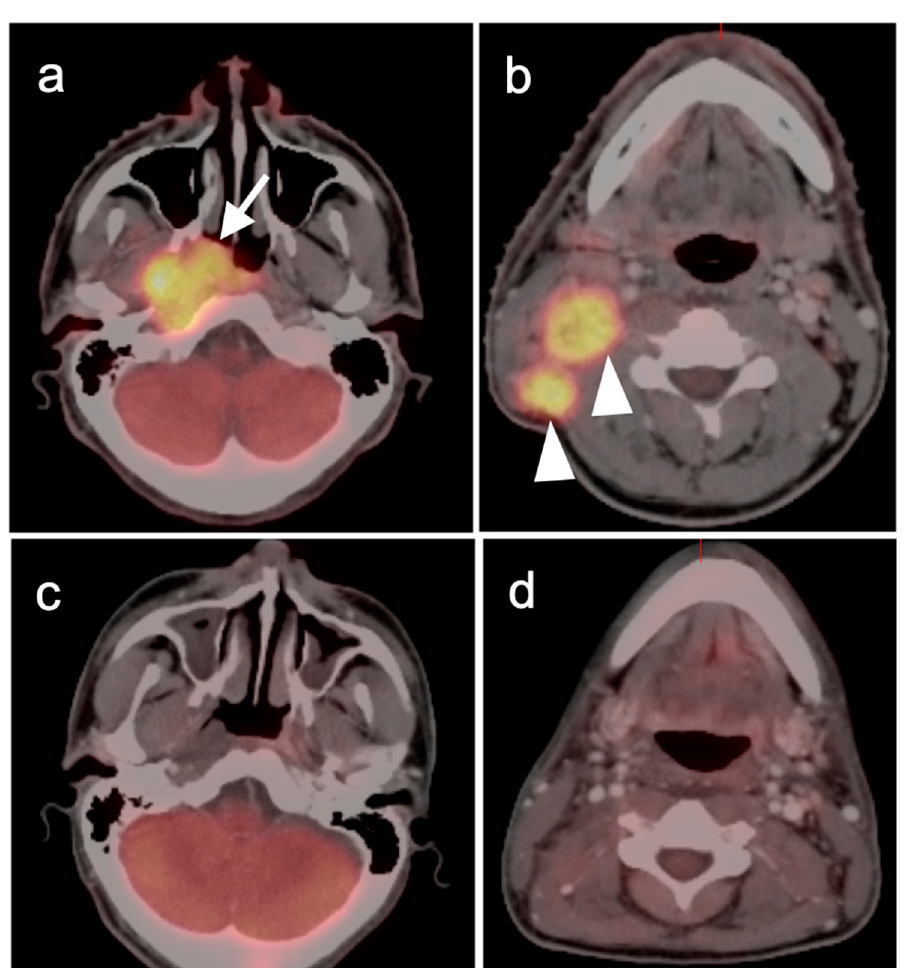
Figure 3. Complete metabolic and anatomic resolution of nasopharyngeal carcinoma. ( a , b ) Pre- treatment FDG PET-CT demonstrates hypermetabolic right nasopharyngeal mass ( a , white arrow) and right pathologic cervical lymph nodes ( b , white arrowheads); ( c , d ) post-treatment FDG PET-CT demonstrates complete anatomic and metabolic resolution of all sites of tumor. Table 1. Hopkins criteria for reporting head and neck cancer response to therapy. Focal uptake in the lesion of interest is compared to that in the internal jugular vein (IJV) and the liver [6]. Hopkins Score FDG Uptake Interpretation Focal uptake < IJV Complete metabolic